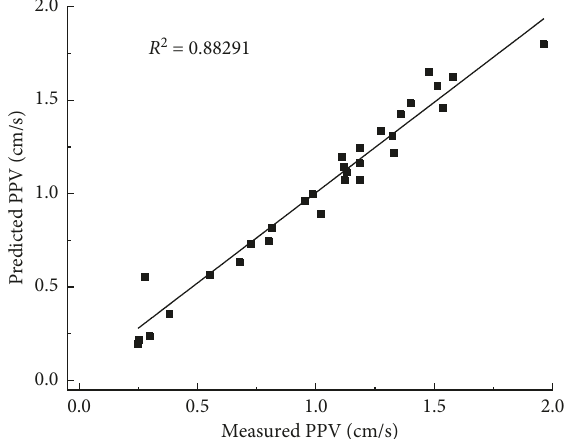
Figure 14: Measured PPVs against predicted PPVs fitted by Sadaovsk formula.